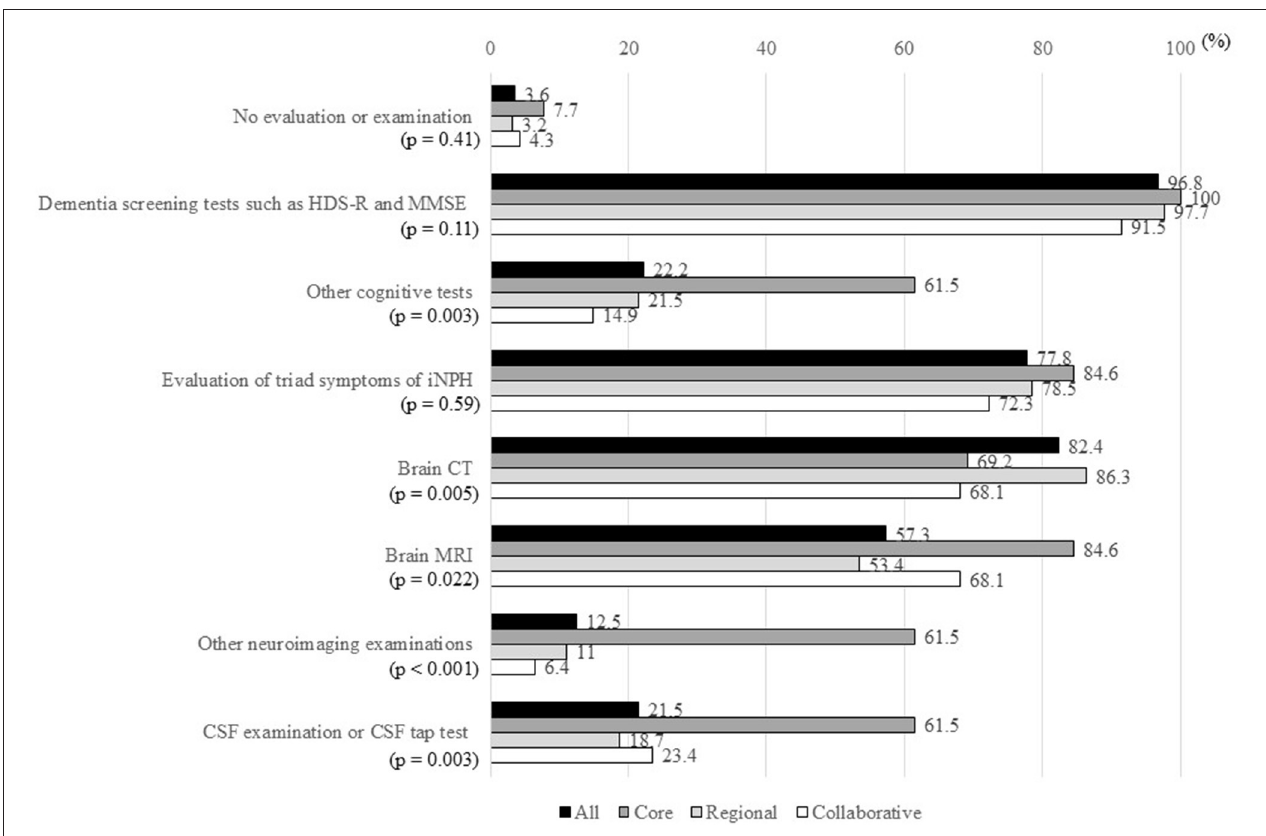
FIGURE 3 | Percentages of MCDs that answered “Yes” to items in response to the question “How do you examine patients with suspected iNPH?”. MCD, medical center for dementia; HDS-R, Hasegawa Dementia Scale-Revised; MMSE, Mini Mental State Examination; iNPH, idiopathic normal-pressure hydrocephalus; CT, computed tomography; MRI, magnetic resonance imaging; CSF, cerebrospinal fluid. *The ratio of “Yes” answers were compared between the three types of MCDs using Fisher’s exact